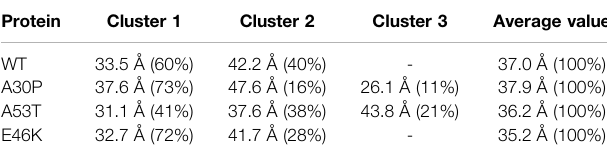
TABLE 3 | Clustering of the gyration radius probability density using the GMM algorithm. The values in brackets are the corresponding % of the ensemble of the